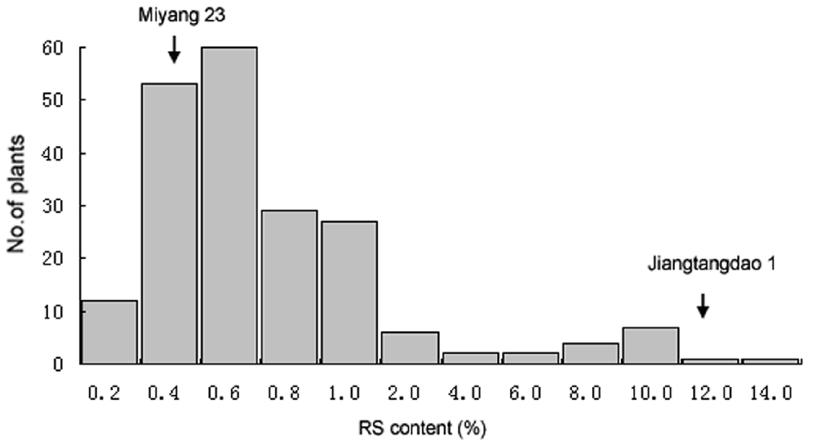
Figure 2. Variation of resistant starch content in the F 2 population derived from Jiangangdao 1 and Miyang 23.